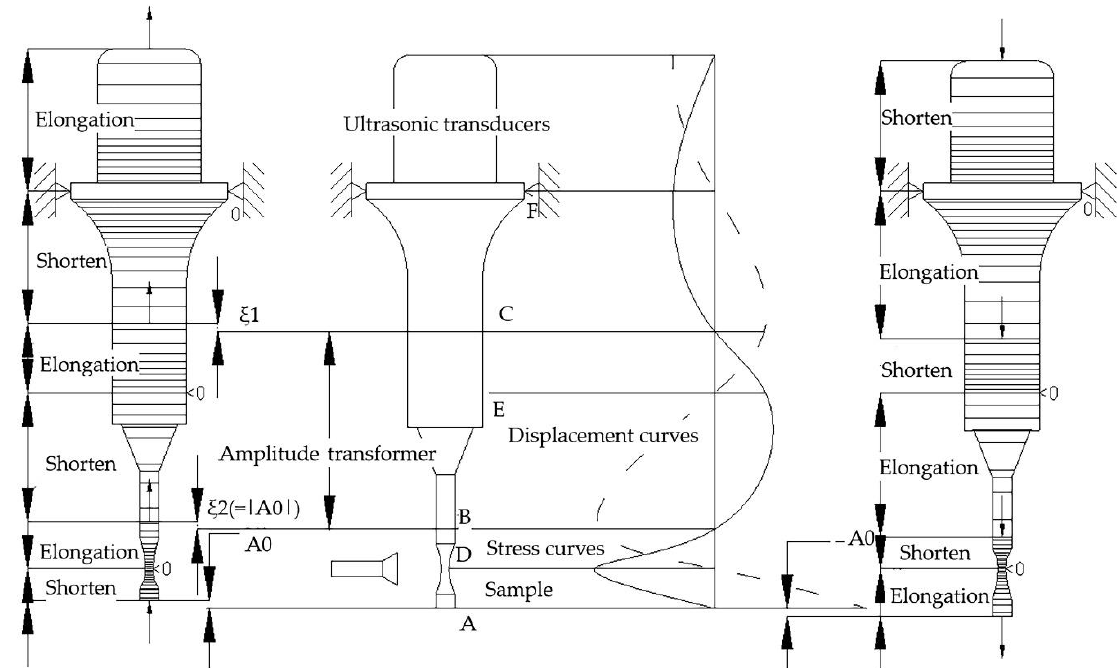
Figure 1. Resonance test system and displacement-stress curve.